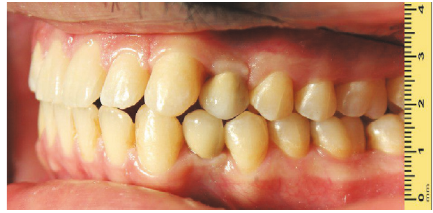
Figure 4: Final restorations for